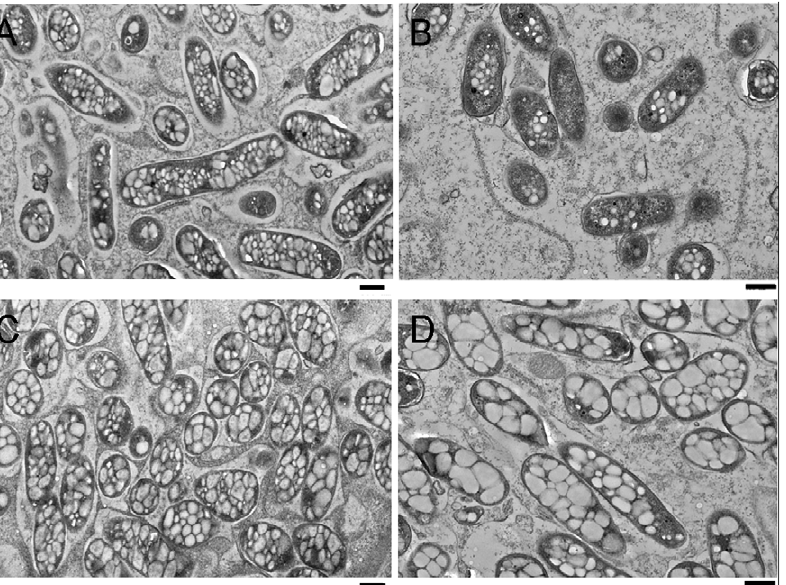
Figure 2. TEM pictures of bacteroids of wild-type (A and B) and RU1933 aapbra (C and D). A and C are pictures taken of 4 week old nodules, B and D of 6 week old nodules. Size bars are 500 m m.